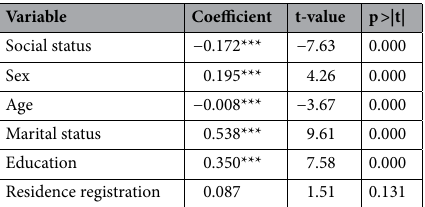
Table 5. The influence of social status on perceived government corruption (N = 14,116). ***p < 0.001, **p < 0.01, *p < 0.05.